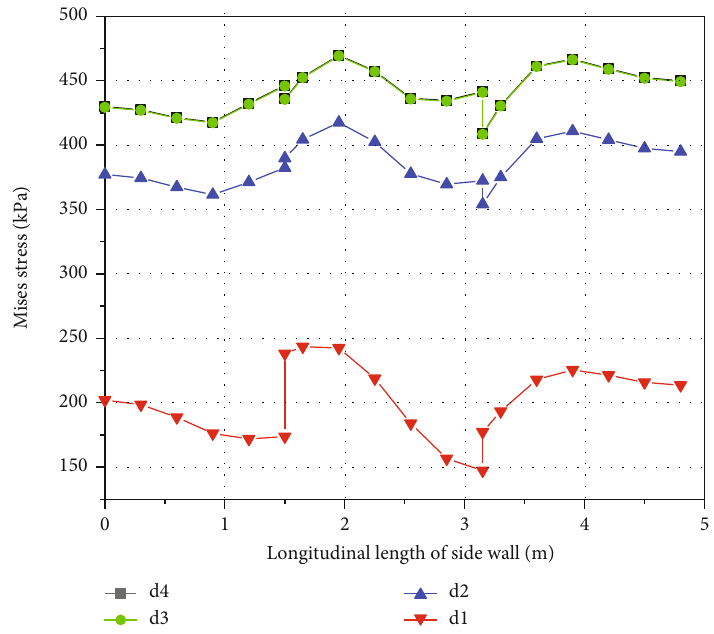
Figure 16: Longitudinal distribution curve of Mises stress on side wall of integrated pipe gallery.